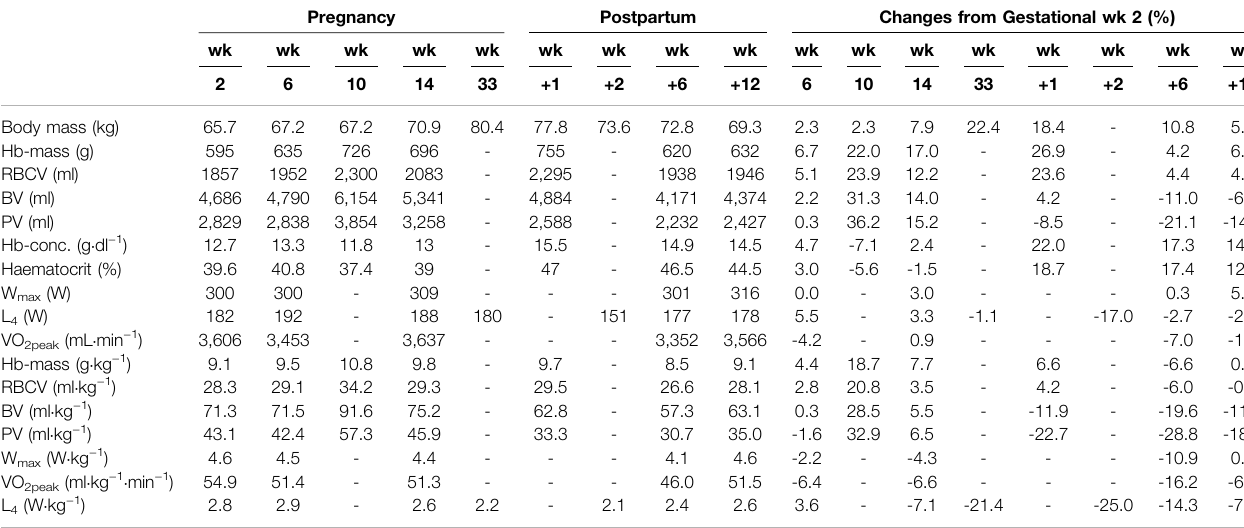
TABLE 1 | Haematological-, and performance-related measures from the beginning of pregnancy (week 2) to 12 weeks (wk+12) postpartum. Pregnancy Postpartum Changes from Gestational wk 2